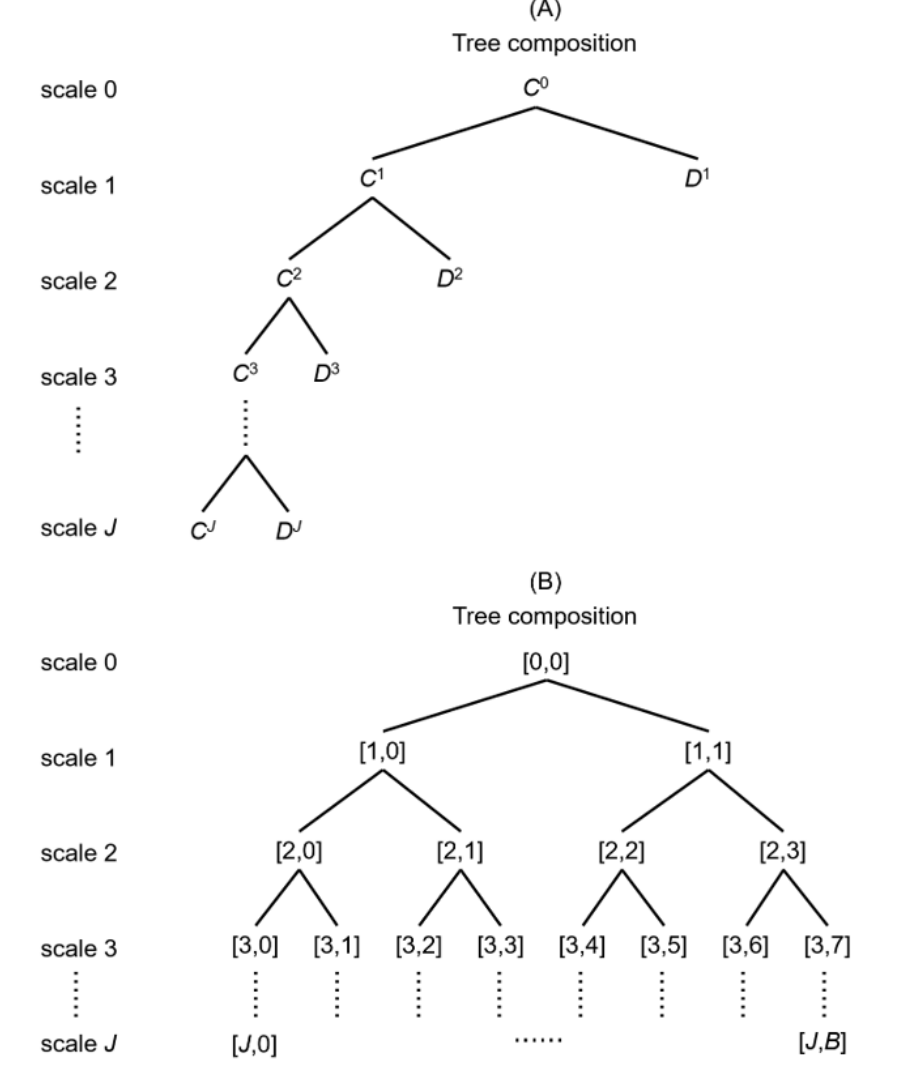
Figure 1. Diagram of DWT ( A ) and WPT ( B ) decomposition.